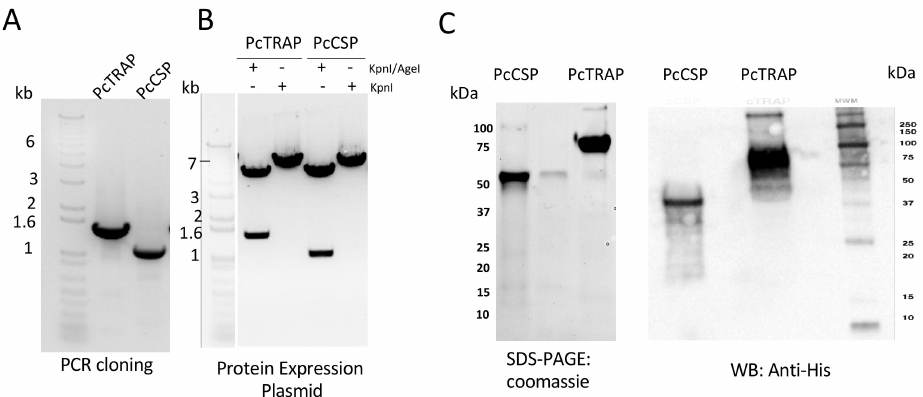
Figure 2. Design and cloning of PcCSP and PcTRAP transgenes for protein expression. ( A ) Agarose (1%) gel showing the PcCSP and PcTRAP PCR products following the restriction with AgeI and KpnI enzymes. ( B ) Agarose (1%) gel showing a single or double digestion with AgeI and KpnI to confirm the insertion of the PcCSP and PcTRAP into the PhLSec plasmid. ( C ) SDS-PAGE coomassie-stained gel (left) and Western blot (WB) with an anti-His monoclonal antibody (right) for detection of PcCSP and PcTRAP proteins upon transfection of HEK293 cells with PhLSec plasmids expressing either